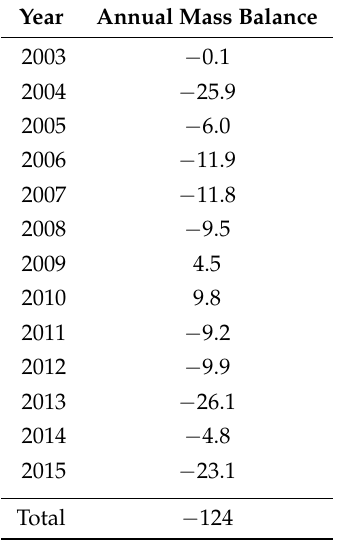
Table 1. Annual Glacier Mass Balance of the NZEM glaciers expressed in Gigatonnes